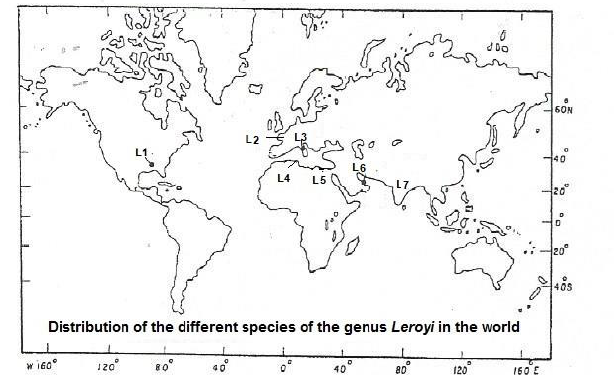
Figure 4. Paleogeographic distributions of the different species of the genus Leroyi in the world: A1: USA, A2: France, A3: Italy ( L. glabra ), A4: Tunisia ( L. tunisiana ), A5: Egypt ( L. aegyptiaca, L. maqfiensis, L. deserti, L. ghorabi ), A6: UAE ( L. ghorabi ), A7: India ( L. glabra